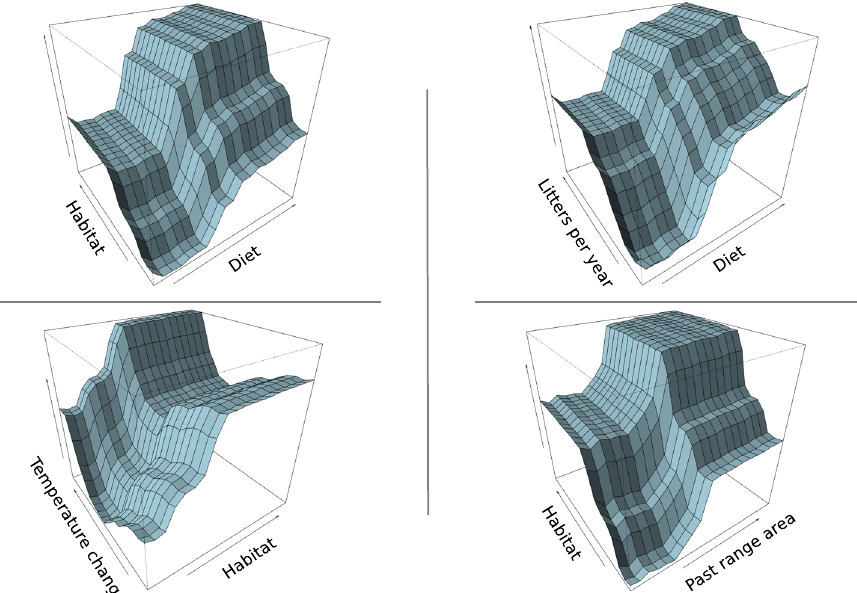
Fig. 4 Partial dependence plots to show the effects of selected pairs of predictors on range expansion. Top-left plot represents the positive interaction of dietary breadth with habitat breadth; the top-right plot shows the positive interaction of dietary breadth with litters per year; the bottom-left plot describes the positive interaction of change in mean annual temperature with habitat breadth; the bottom-right plot illustrates the positive interaction of habitat breadth with the size of the past range on range